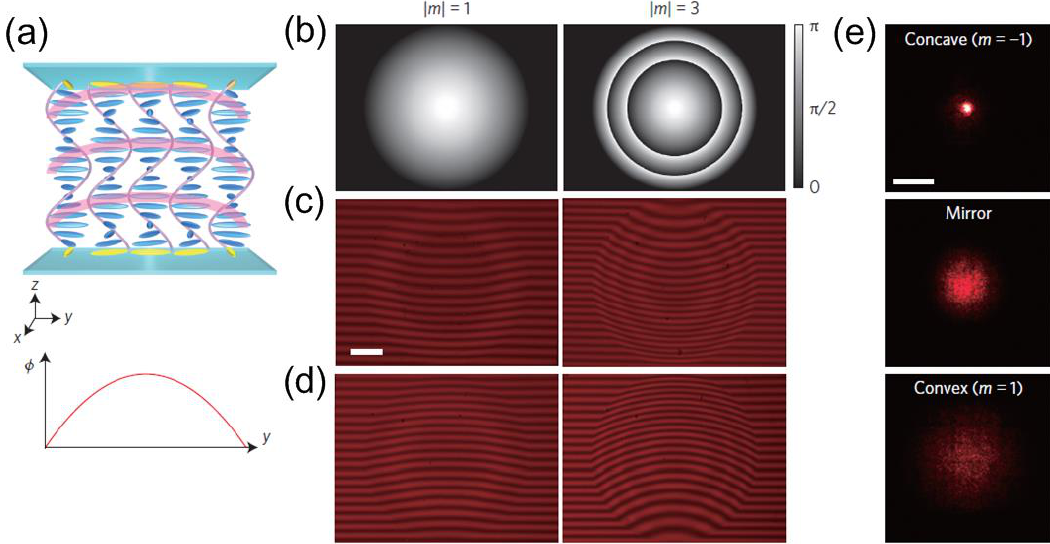
Figure 6. ( a ) Sketch of the working mechanism of metasurface based reflective lenses combined with patterned cholesteric liquid crystals (ChLCs) and the corresponding phase profile. ( b – d ) Device performance for different phases of π and 3π. Scale bar denotes 200 µm. ( e ) Recorded laser spot reflected from different interfaces compared with a mirror. Concave and convex profiles have been recorded for m = −1 and m = 1, respectively. Scale bar denotes 2 mm. Reproduced with permission from [108]. Copyright Springer Nature, 2016.